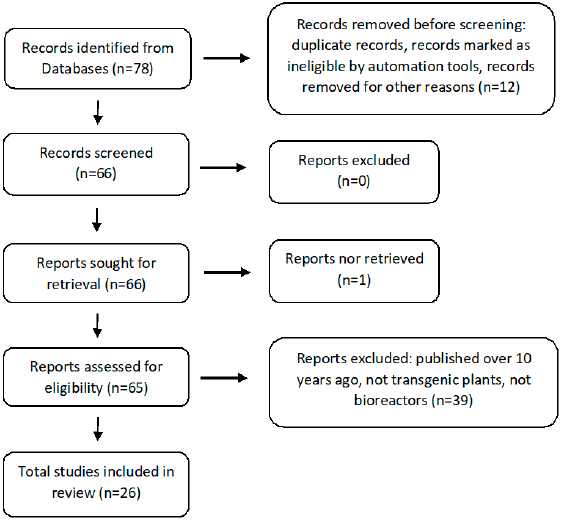
Figure 1. PRISMA flow diagram demonstrating screening method for article [26].